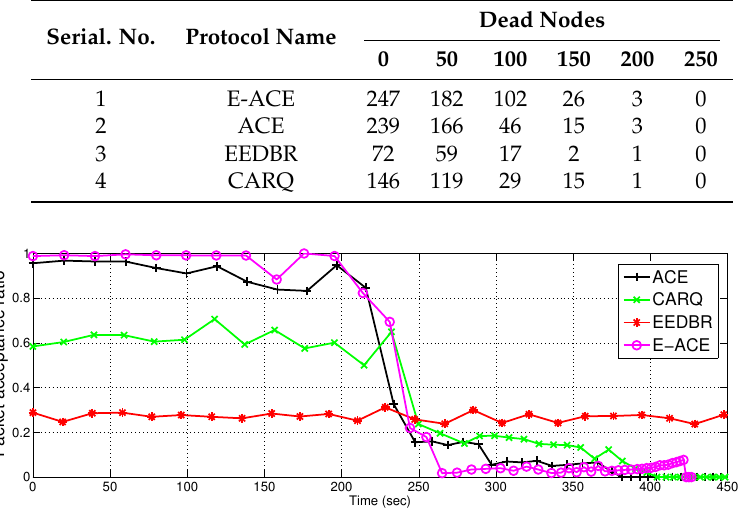
Table 2. Throughput vs. dead nodes.